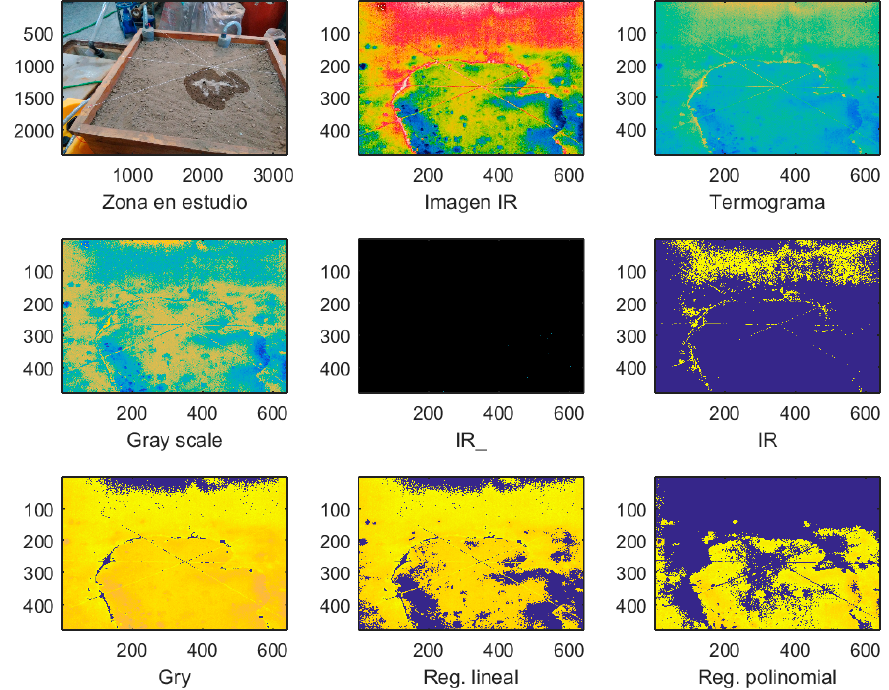
Figure A8. Image results with MATLAB algorithms. Test ID: